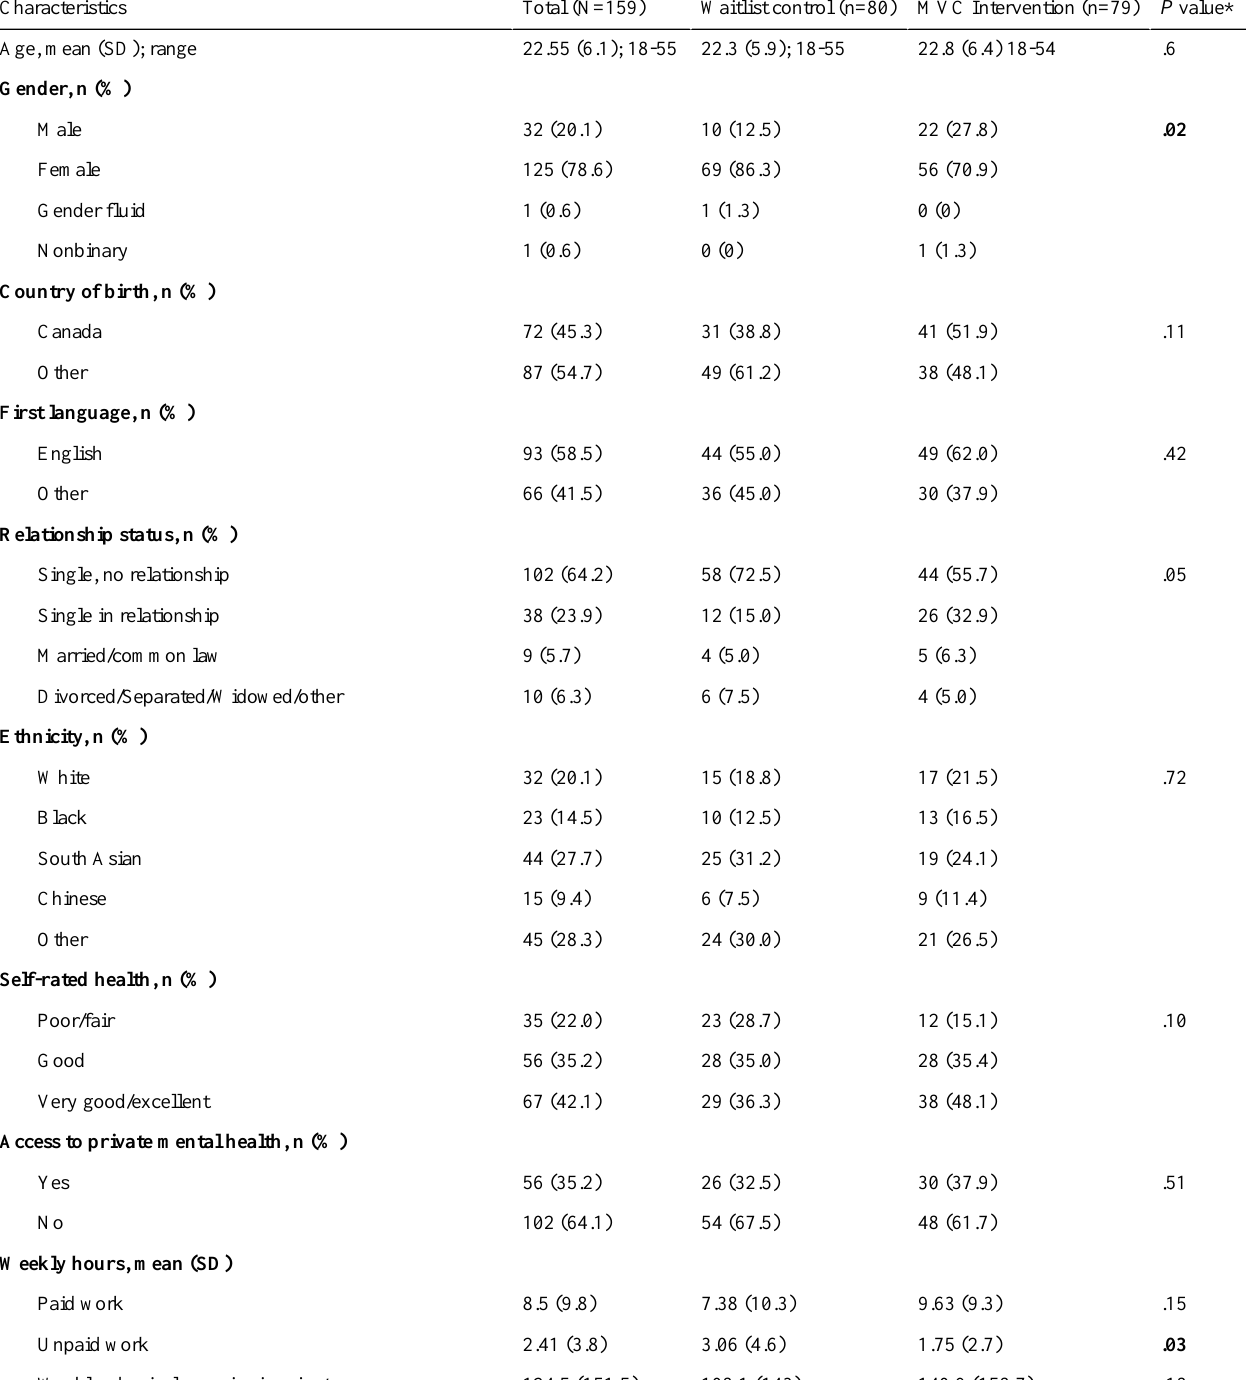
Table 2. Participant